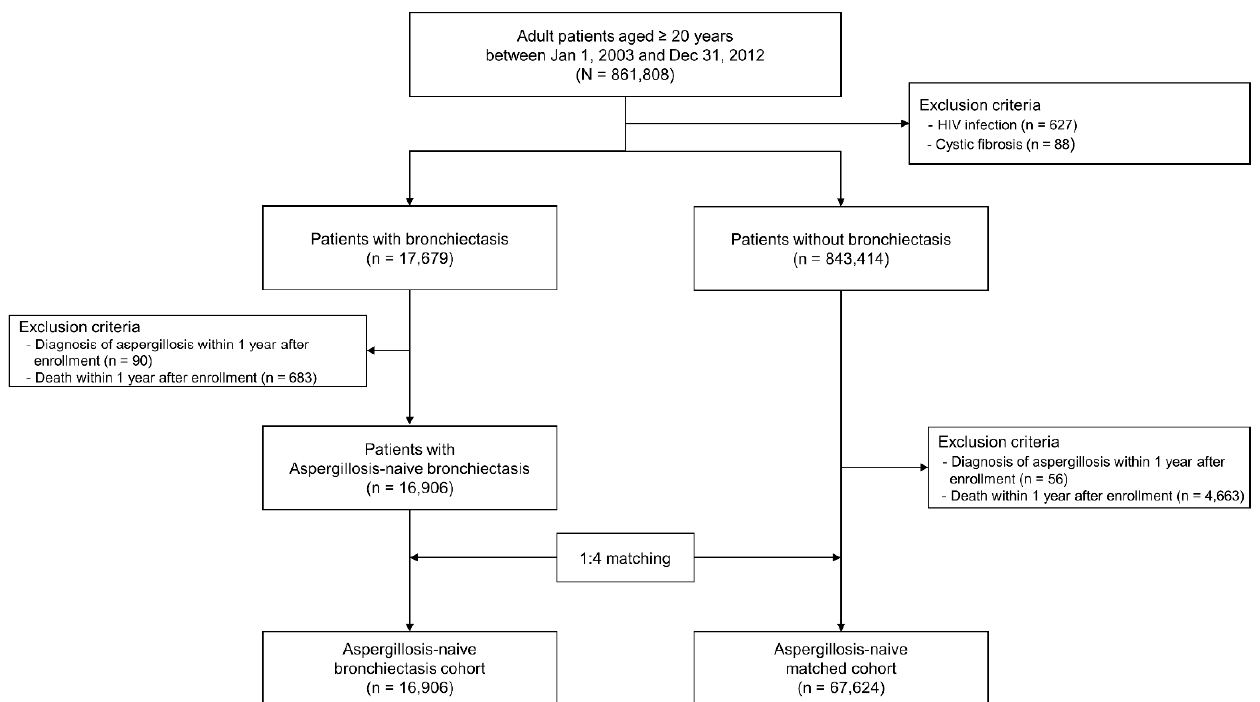
Figure 1. Flow chart of the study. HIV, human immunodeficiency virus.